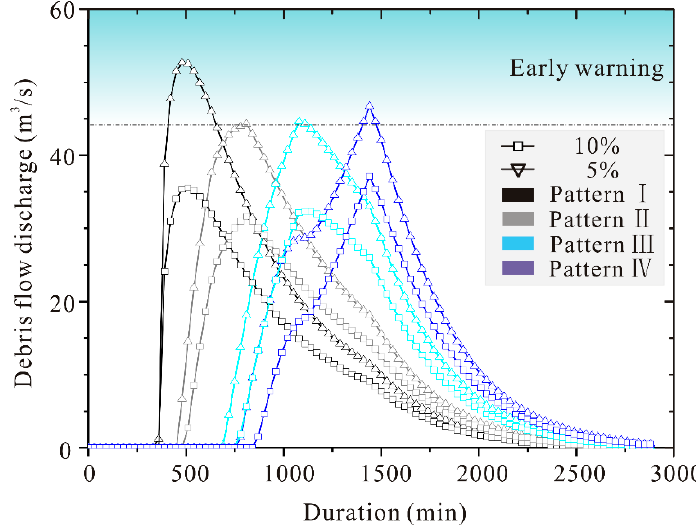
Figure 12. Discharge (no consideration of blocking while D c = 1.0) of B-B’ under the conditions of di ff erent rainfall patterns. Square represents the debris flow discharge induced by rainfall at the frequency of 10%; inverted triangle represents the debris flow discharge induced by rainfall at the frequency of 5%; dash / dot line represents the critical discharge on